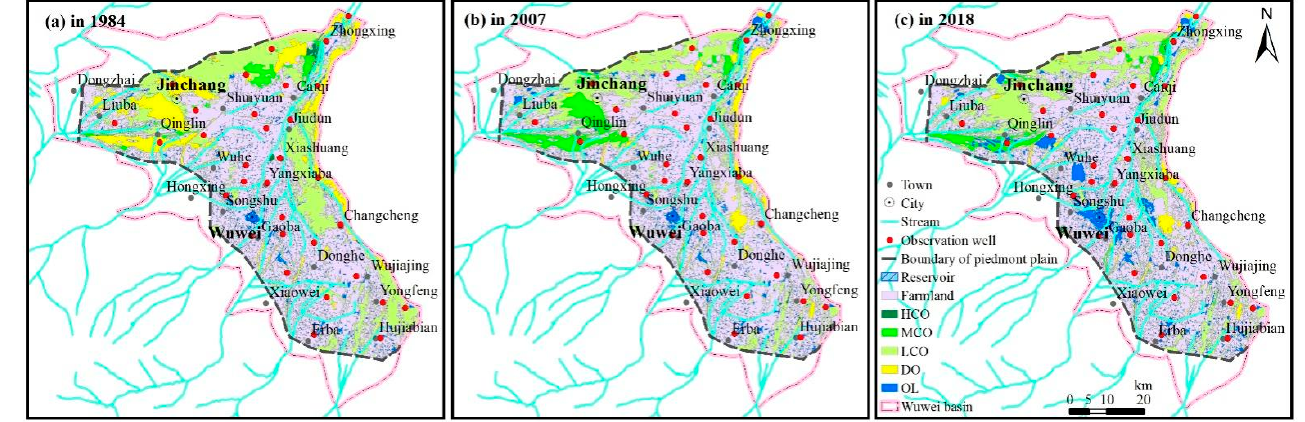
Figure 5. Distributions of land use/cover types, ( a ) in 1984, ( b ) in 2007, and ( c ) in 2018. Table 1. Transition matrix of the land-cover types (km 2 ).